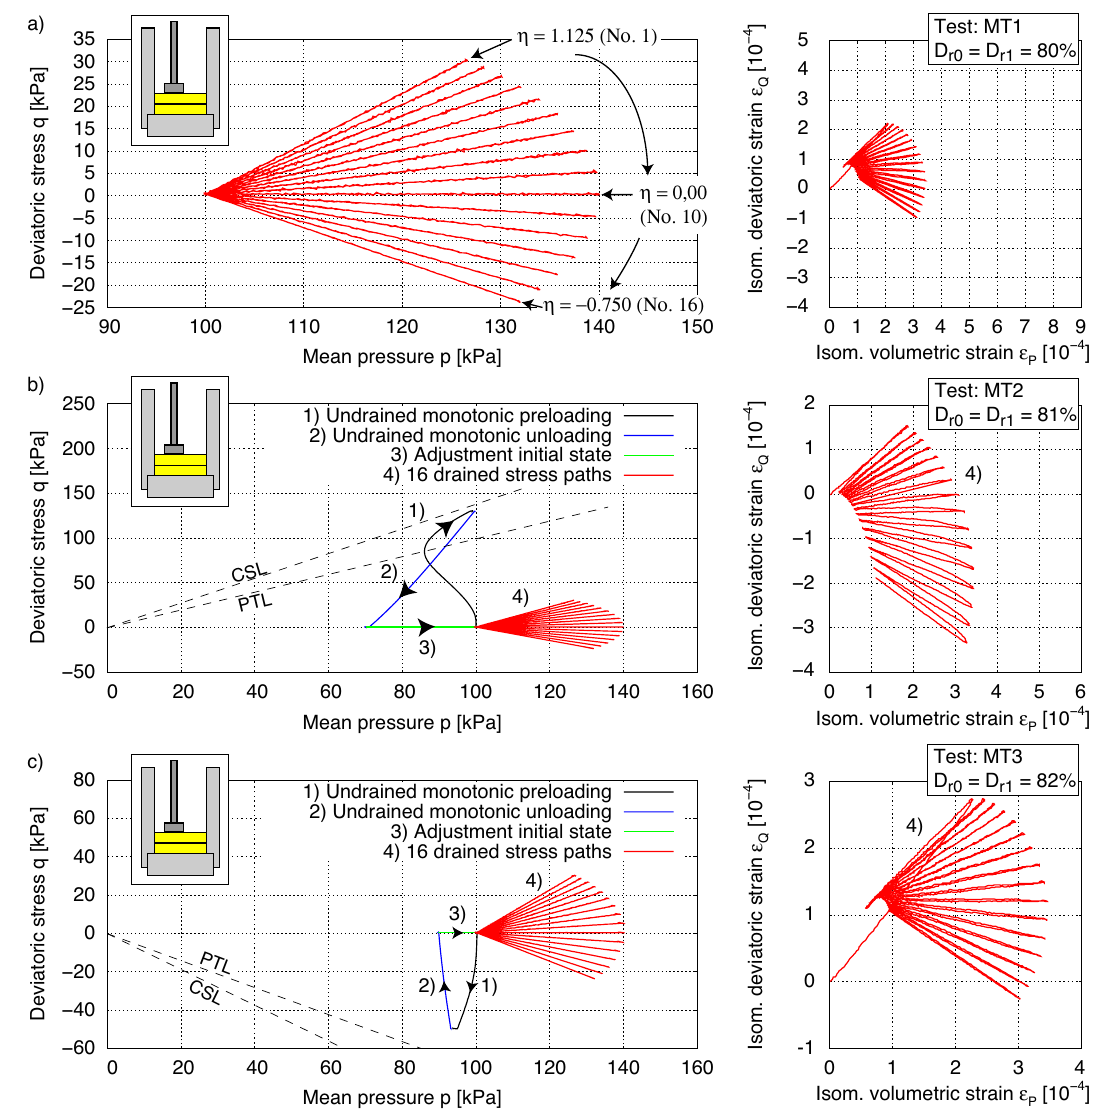
Figure 7. Test results on KFS with a critical friction angle ϕ c = 33.1 ◦ : ( a ) without preshearing history of Test MT1 as reference test, ( b ) preshearing history in compression area of Test MT2 with mobilized friction angle ϕ mob = 32.7 ◦ and ( c ) preshearing history in extension area of Test MT3 with mobilized friction angle ϕ mob = 16.9 ◦ . D r 0 after sample preparation (moist tamping) and D r 1 at start of drained stress